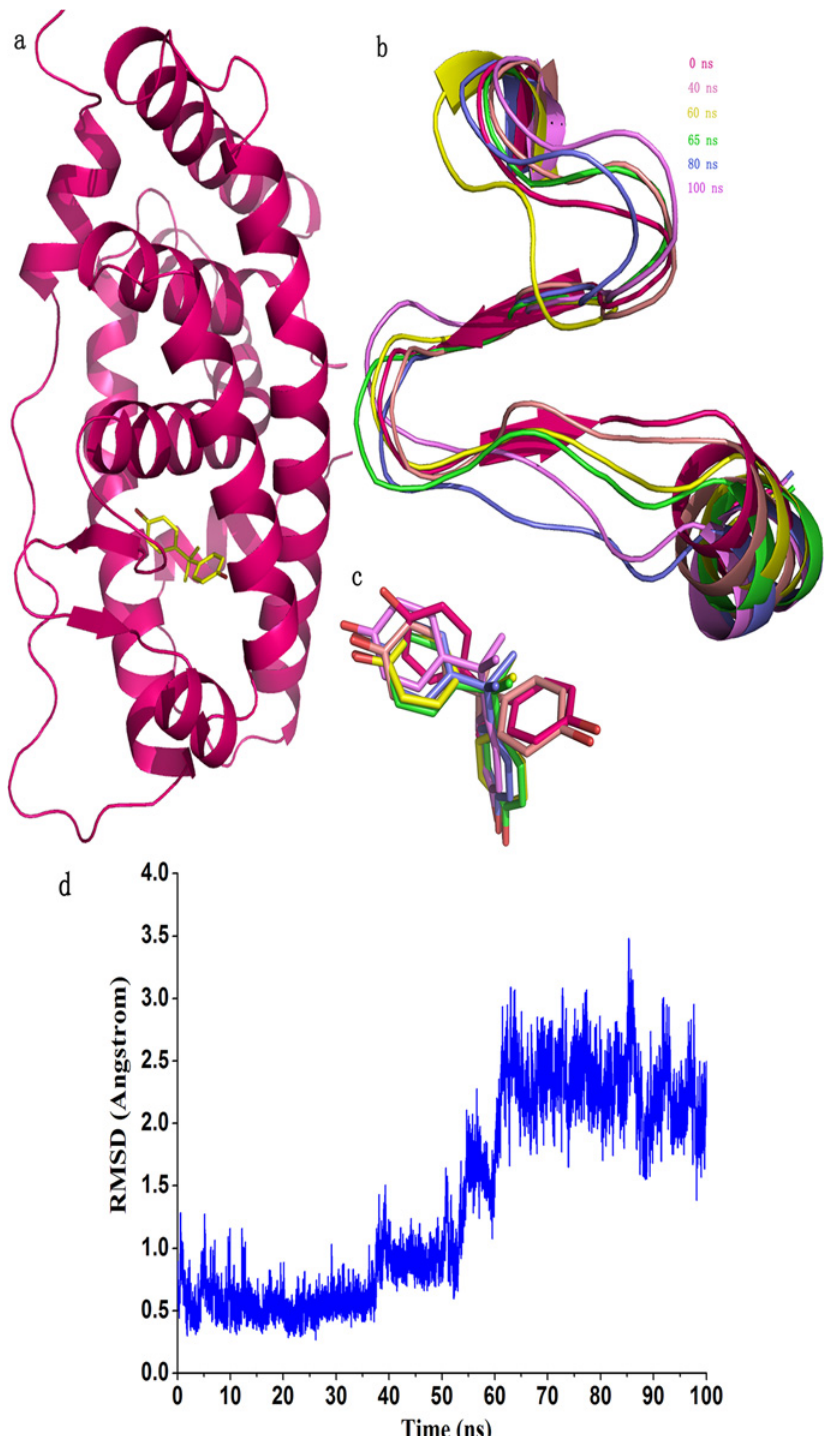
Fig 3. Conformation change of H6, β 1 and β 2 of hERR γ (residues 317 – 341). a) The initial structure of the protein with BPA shown in yellow sticks; b) The conformations of the studied regions at different times; c) The poses of BPA in the binding pocket at different times; d) Time revolution of the RMSD of backbone atoms of residues 317 – 341.